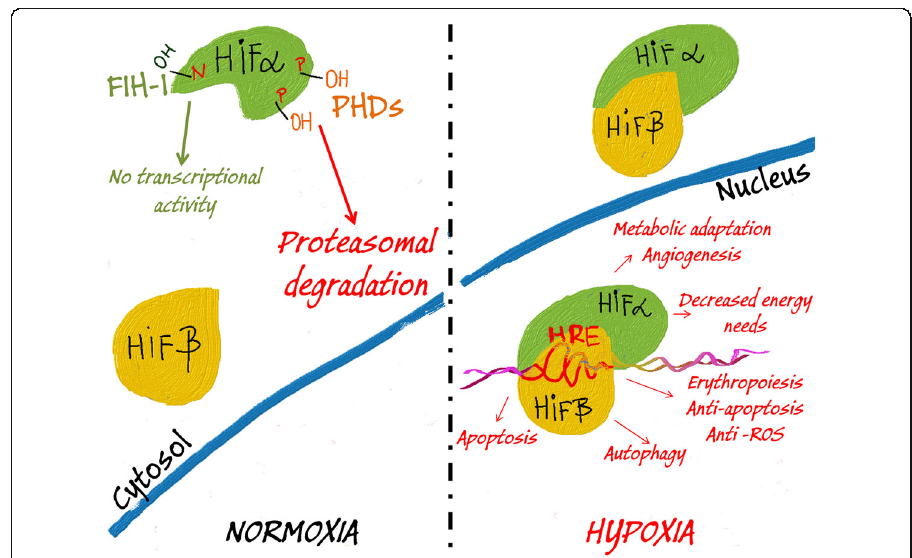
Fig. 1 Oxygen availability regulates HIF signaling. In normoxia, proline (P) residues on HIF α subunits are hydroxylated by PHDs that marks them for proteasomal degradation. Additionally, FIH-1 mediates hydroxylation of asparagine residues (N) on HIF α to prevent HIF transcriptional activity. Hypoxia impairs the ability of PHDs and FIH-1 to hydroxylate the HIF α subunits, and thus results in the accumulation of this subunit and its heterodimerization with the stable HIF β subunits. In the nucleus, the HIF α / β complex binds to HRE elements in the HIF target genes and governs their expression in order to adapt the cells to hypoxic